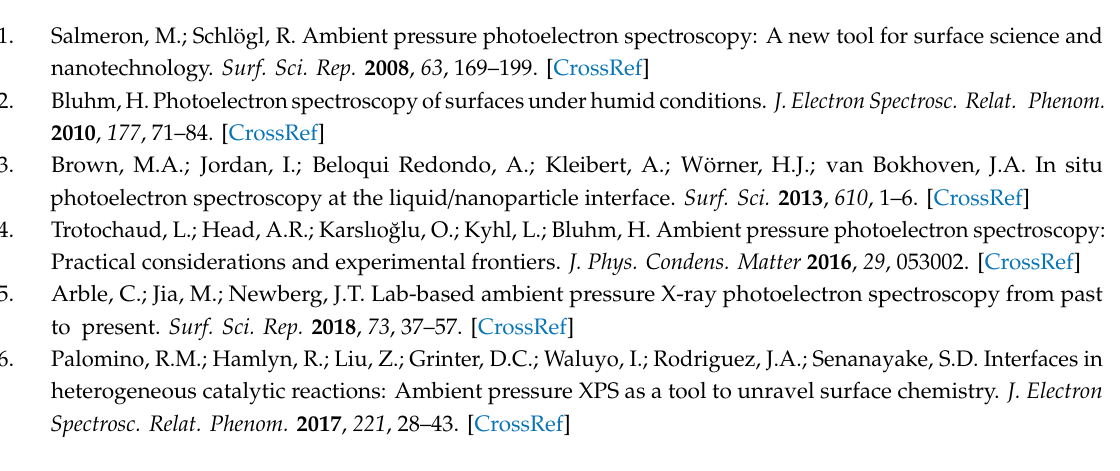
Figure S1: F 1s and P 2p core-level spectra of LP30 electrolyte and in contact with a V 2 O 5 single crystal at 10 mbar, Figure S2: F 1s and P 2p core-level spectra of the immersed V 2 O 5 single crystal after cleaning with EtOH, Figure S3. V 2p core-level spectra of a pristine V 2 O 5 single crystal and in contact with the LP30 electrolyte at 10 mbar, Figure S4: Li 1s core-level spectra of the V 2 O 5 single crystal after immersion in LP30 electrolyte and cleaning with EtOH, Figure S5: P 2p core-level spectrum of LP30 electrolyte at 10 mbar, Figure S6: Decrease of the O 2 peak at ~538eV in the O 1s core-level spectra of LiTFSI electrolyte, initially and after 40 min at 1 mbar, Figure S7: Li 1s, S 2p, and N 1s core-level spectra of LiTFSI in PC electrolyte at 2 mbar, Figure S8: Survey spectra and quantification results after carbon contamination correction of the pristine V 2 O 5 single crystal and after immersion in LiP30 6 electrolyte and cleaning with